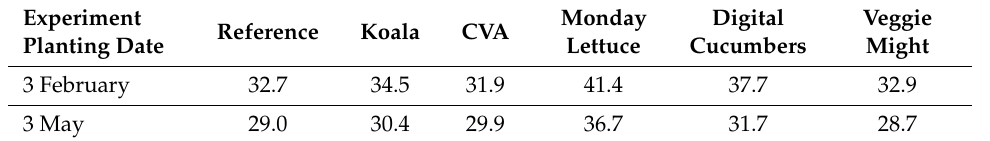
Table 2. Net profit of different teams in the second experiment consisting of crop income minus costs (fixed costs, heating costs, electricity costs, CO 2 costs, and intervention costs).